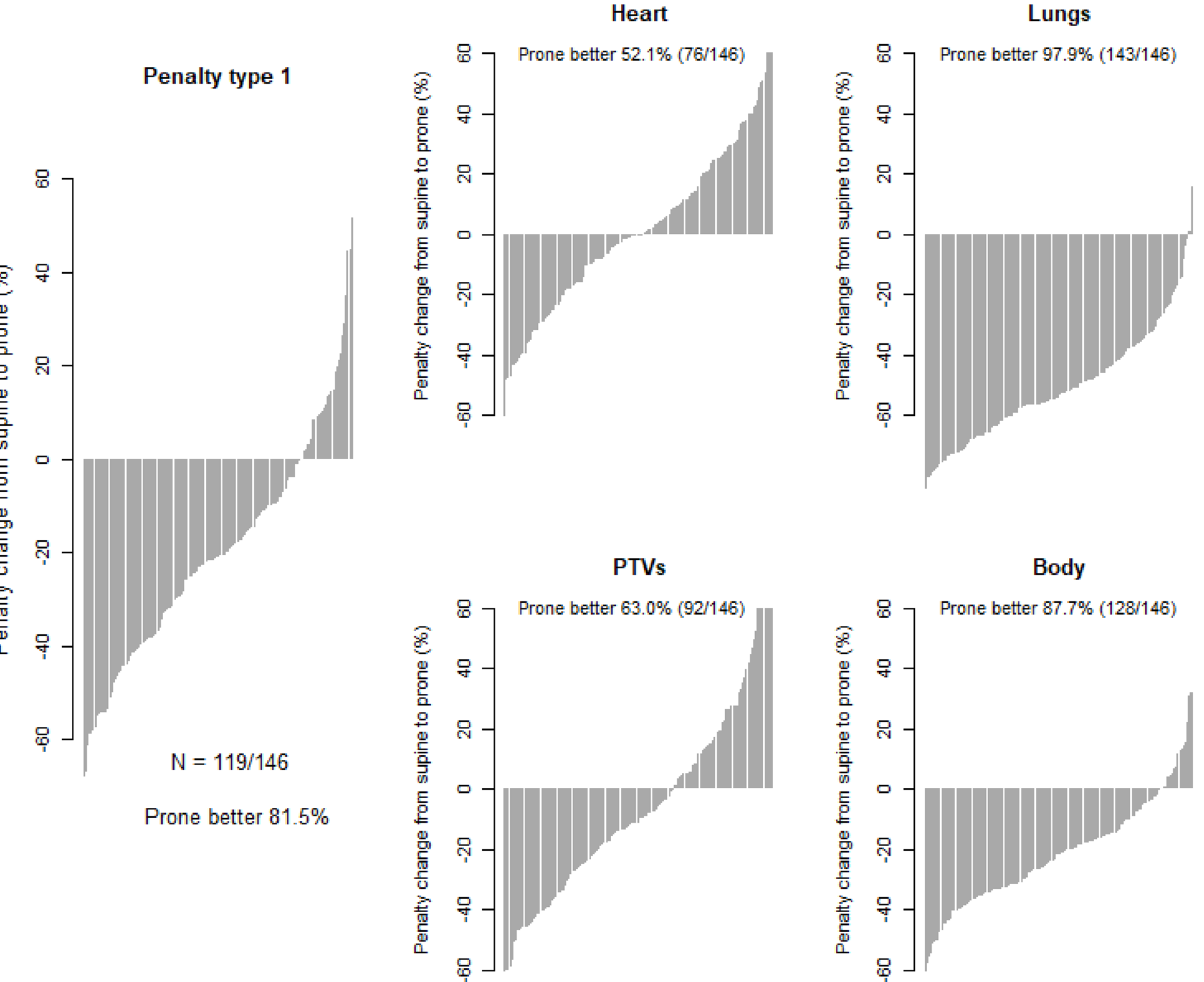
Figure 5. Waterfall plot of percent penalty change from supine to prone.